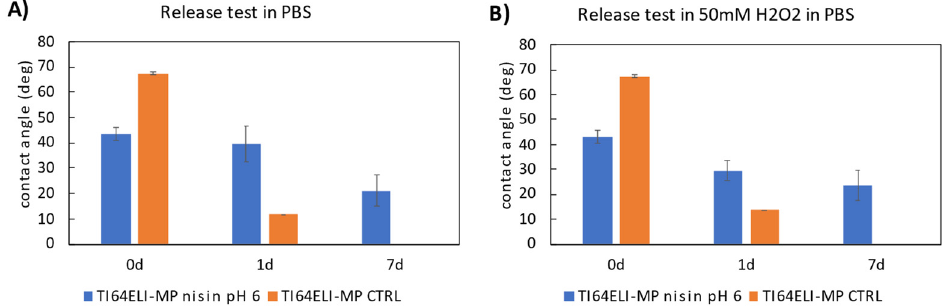
Figure 9. ( A ) The contact angles measured from non-soaked (0 d) and PBS- soaked (1 d, 7 d) samples. ( B ) The contact angles measured from non-soaked (0 d) and H 2 O 2 - soaked (1 d, 7 d) samples. Functionalization has been performed at pH 6.